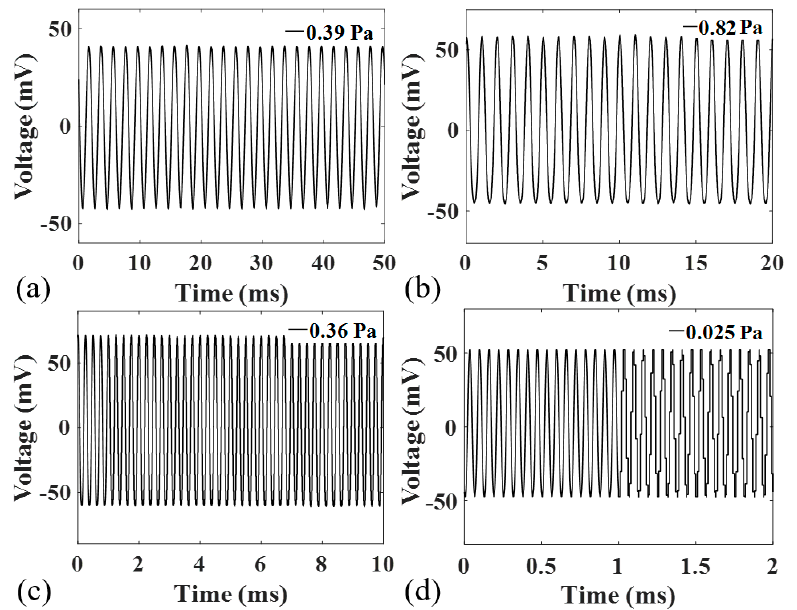
Figure 6. The measured time–domain response of the FPI sensor for the detection of acoustic waves with frequencies of ( a ) 500 Hz, ( b ) 1 kHz, ( c ) 4 kHz and ( d ) 16 kHz.